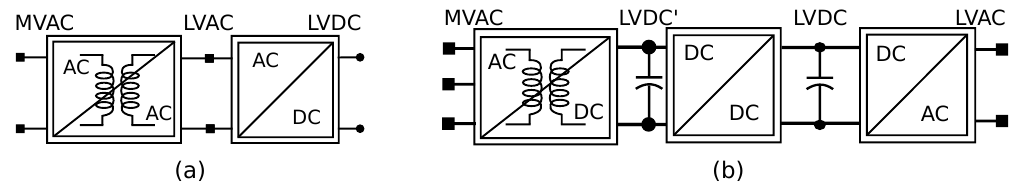
Figure 3. SST topologies excluded from the existing SST terminology: ( a ) SPDS AC (cid:107) AC/DC SST [16] and ( b ) SPTS AC (cid:107) DC/DC/AC SST